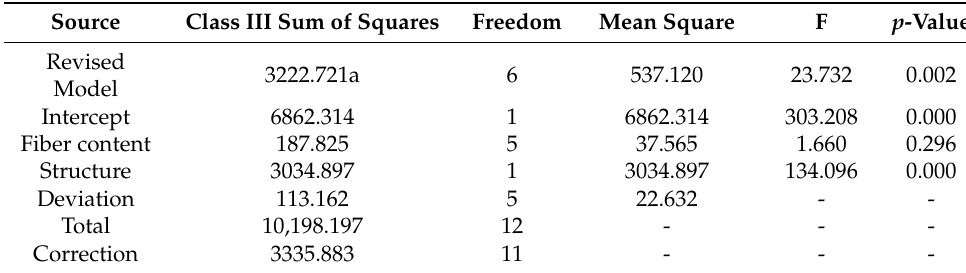
Table 3. Results of the two-way ANOVA. Source Class III Sum of